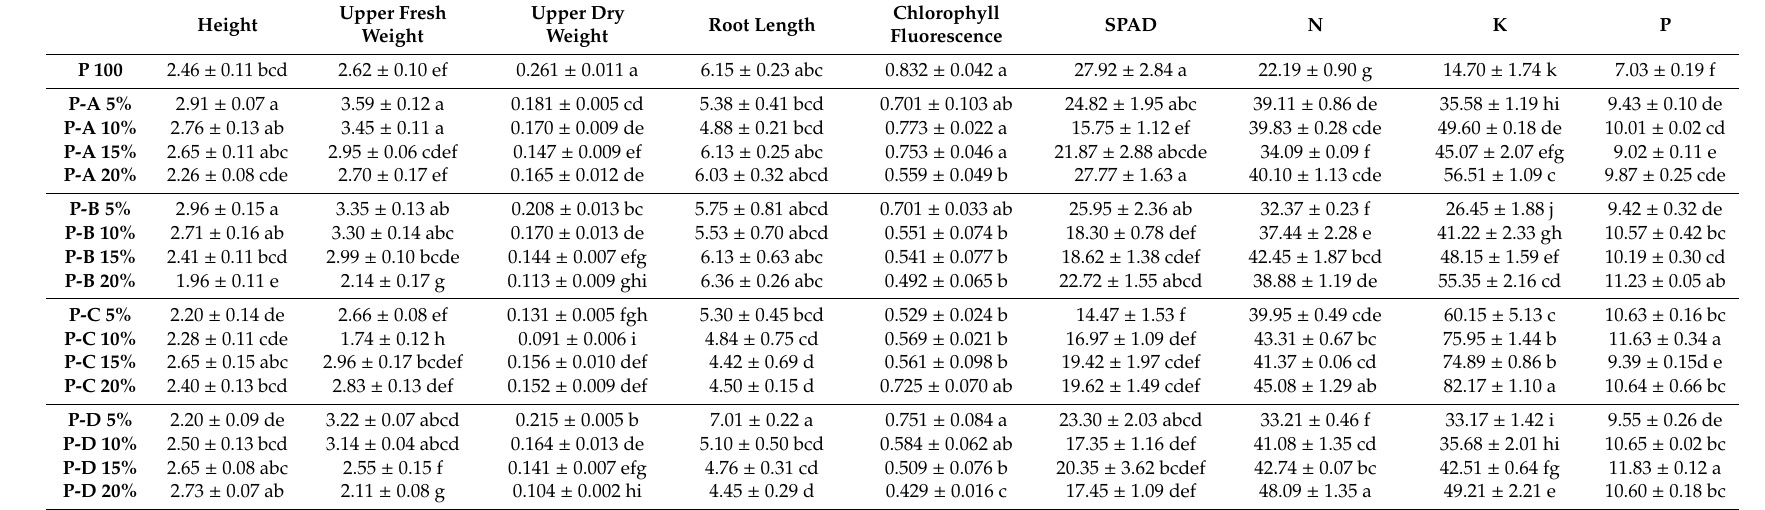
Table 3. E ff ects of peat (P 100) with di ff erent biochar types (A, B, C, D) and ratio (0-5-10-15-20%) on plant growth (height in cm, upper fresh weight in g, upper dry weight in g, root length in cm), chlorophyll fluorescence (Fv / Fm), chlorophyll content (SPAD units), and minerals content (N, K, P in g kg − 1 ).